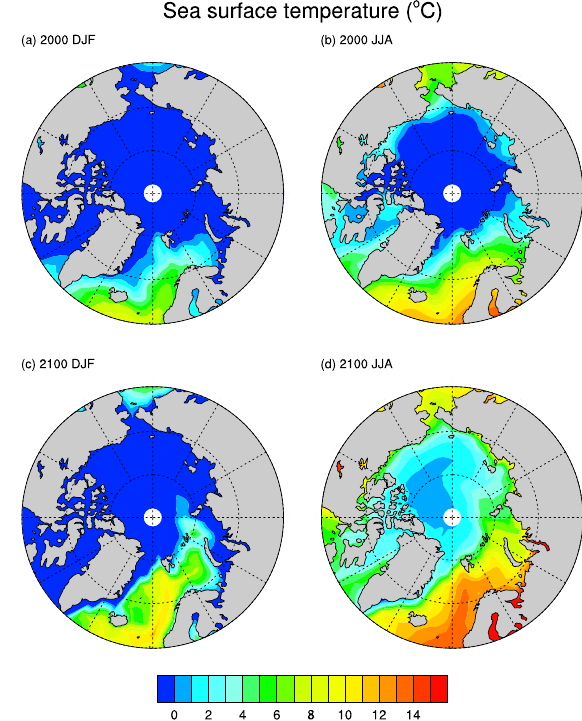
Fig. 4. Winter (DJF) and summer (JJA) sea surface temperature prescribed in the model: 2000 climatology from Hurrell et al. (2008), 2100 climatology derived using an average of three ensem- ble CCSM3 model simulations based on the A1B SRES